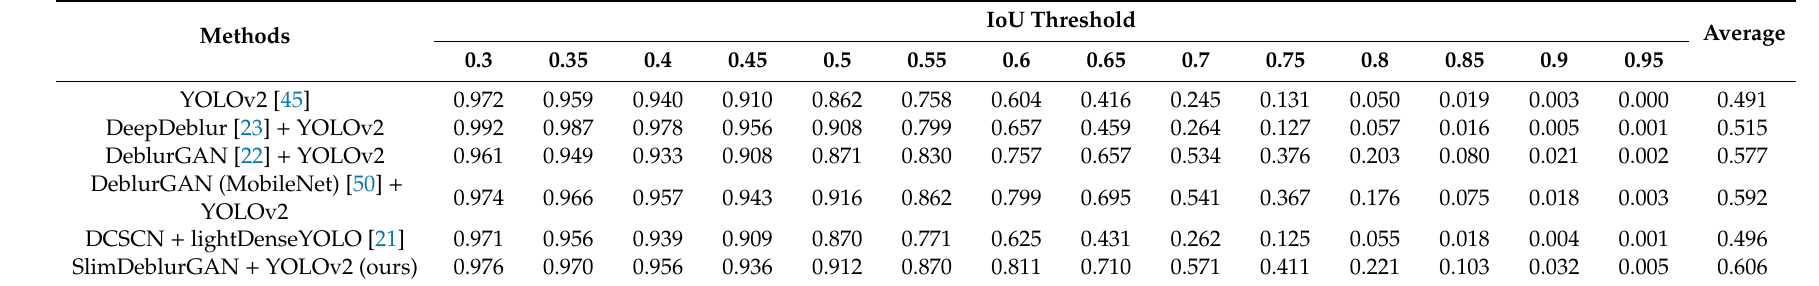
Table 12. Comparisons of precision on RMBD-DB1.